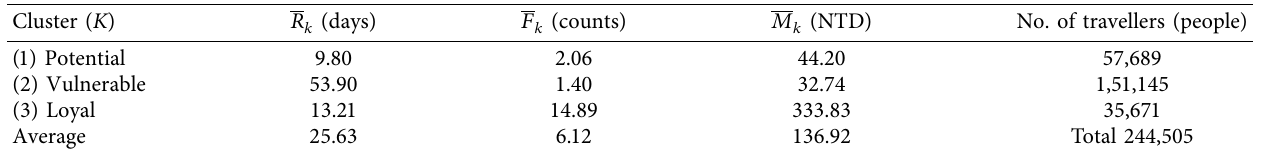
Table 11: Clustering results by K -means for 2018 Q